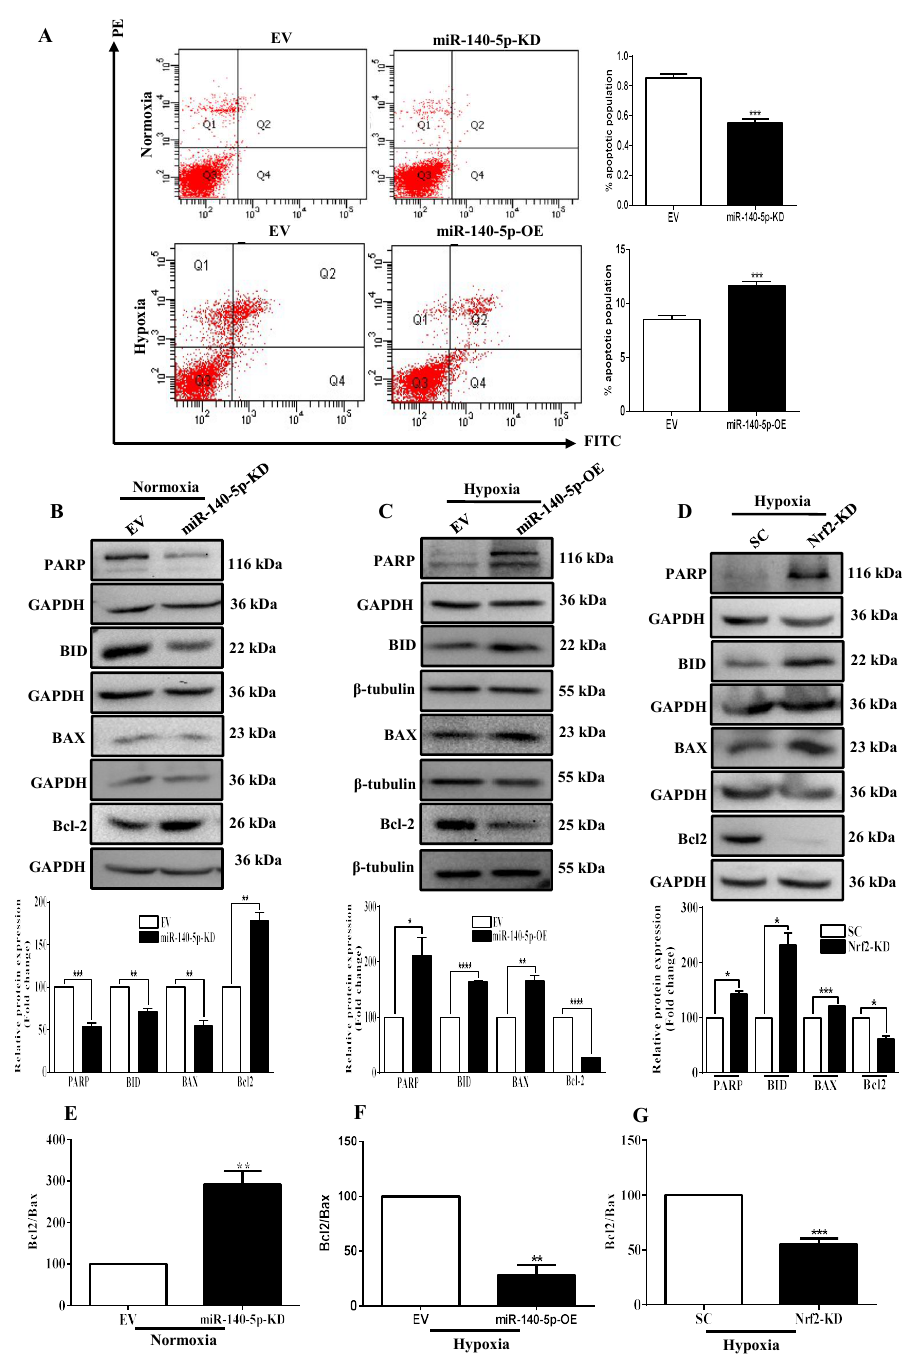
Figure 7. miR-140-5p induces BC cell apoptosis in vitro. ( A ) The effect of miR-140-5p knockdown under normoxia or overexpression under hypoxia on apoptosis as measured by flow cytometry. ( B – D ) The levels of apoptotic markers in miR-140-5p-KD cells under normoxia ( B ), miR-140-5p-OE cells under hypoxia ( C ), or Nrf2-KD cells under hypoxia ( D ) as measured by Western blotting and its densitometry by image J software. ( E – G ) Bcl-2/Bax ratio after miR-140-5p knockdown under normoxia ( E ), miR-140-5p-OE under hypoxia ( F ), or Nrf2-KD under hypoxia ( G ). Error bars indicate mean ± SEM ( n = 3). Student’s t -tests were used to compare the means of two groups. * p < 0.05, ** p < 0.01, *** p < 0.001, and **** p < 0.0001 compared to